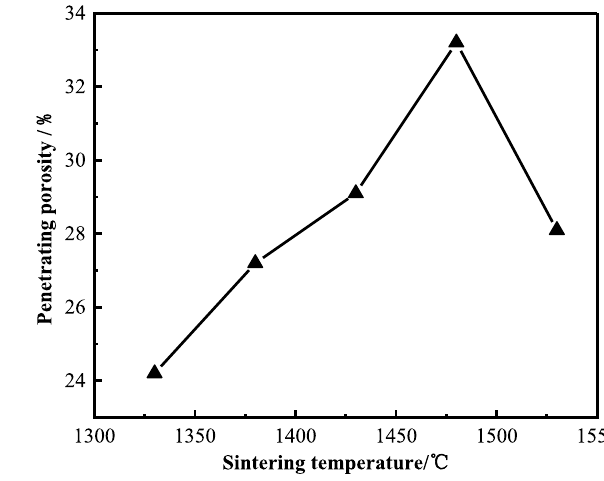
Fig. 8 Pure water flux with the pressure drop results from the cross- filtration test for the support samples SM prepared at different sinter- ing temperatures